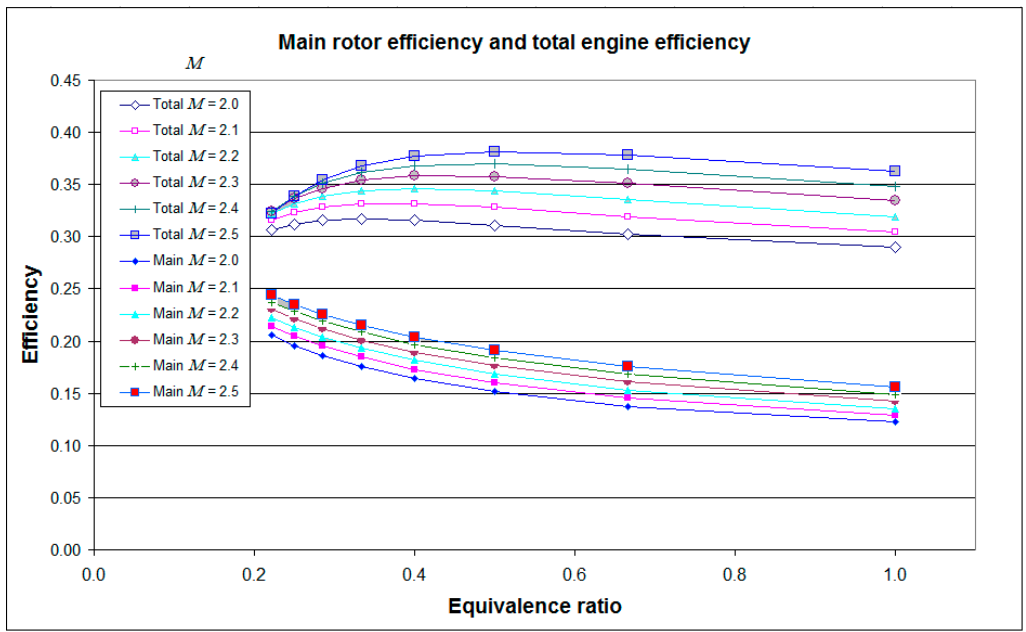
Figure 11. Estimated power of the main and auxiliary rotors and the total engine power at an inlet Mach number 2.5 in relation to the equivalence ratio.